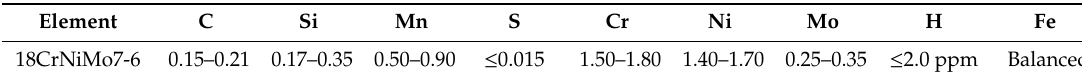
Table 1. Chemical composition of 18CrNiMo7-6 steel